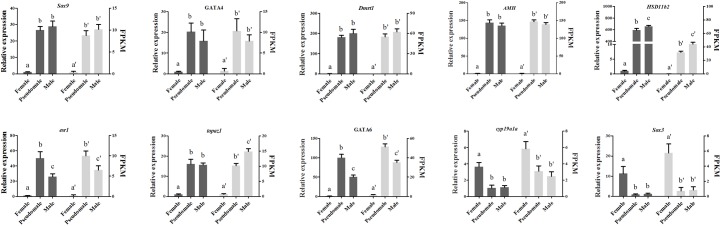
Verification of the expression patterns both in qRT-PCR and RNA-seq. The data was shown as mean ± SD (n = 6). Groups with different letters were significantly different (P < 0.05).